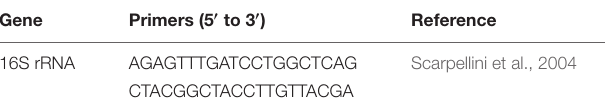
TABLE 1 | Primer sequences used in the study.